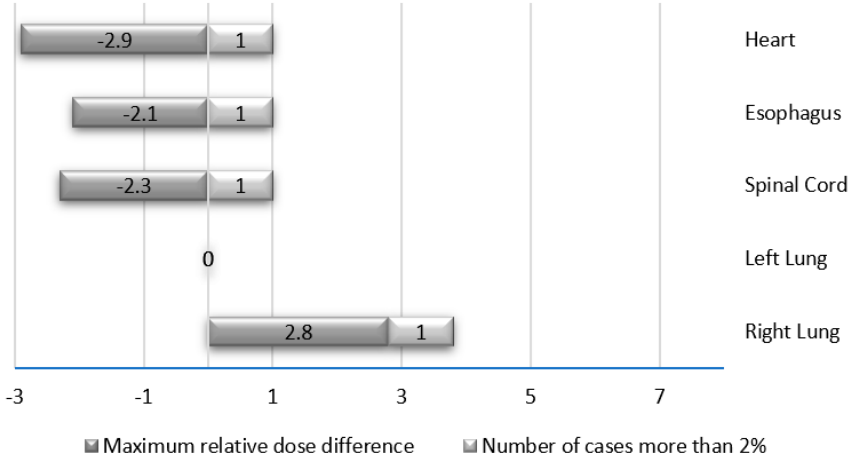
Figure 4. No. of patients greater than 2% relative dose difference between NCCT and CCT for mediastinum critical structures.